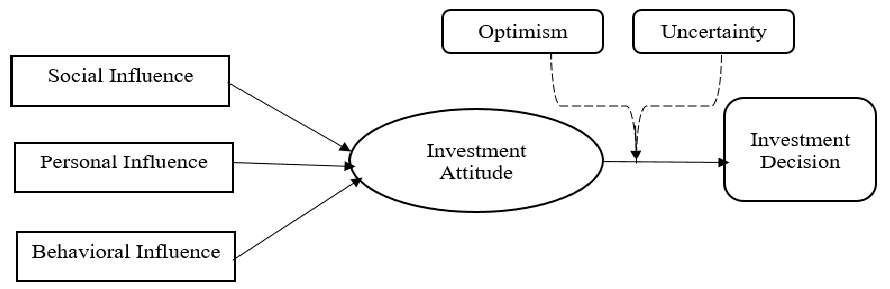
Figure 4. Model Proposed for Factors Affecting Women Investment Attitude.